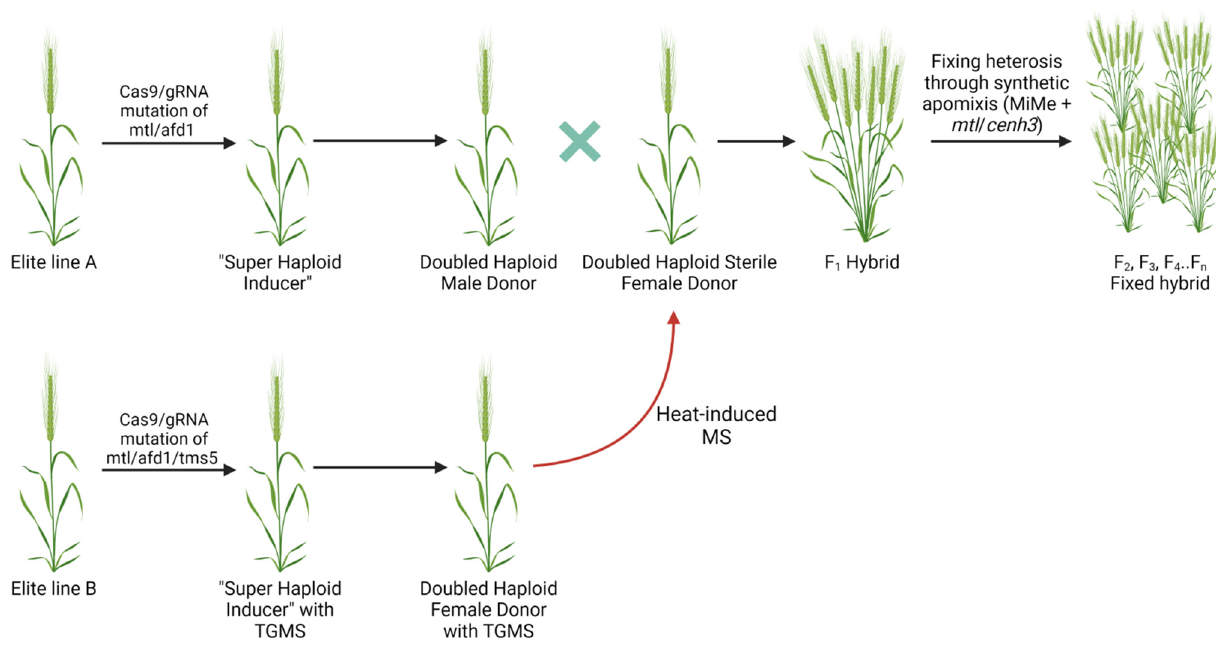
Figure 3. Hypothetical scheme for achieving and fixing heterosis by editing genes involved in haploid induction, sponta- neous doubling, thermosensitive genic male sterility (TGMS), and mitosis instead of meiosis phenotype. First, selected elite lines A and B capable of generating the F 1 progeny with hybrid vigor are converted into “super haploid inducer” lines through the mtl / afd1 double mutation. ‘Super haploid inducers’ can generate haploids capable of producing fertile DH plants at a high rate through spontaneous chromosome doubling. The tms5 mutation is also introduced in the genome of the female donor to facilitate heat-induced male sterility. The female DH sterile donor is pollinated with the male DH donor plant pollen to generate the F 1 hybrid. Eventually, the hybrid vigor can theoretically be fixed through synthetic apomixes. MTL — MATRILINEAL, afd1 — absence of first division1 , tms5 —gene involved in thermosensitive genic male sterility in rice, MiMe—mitosis instead of meiosis, MS—male sterility. Created with